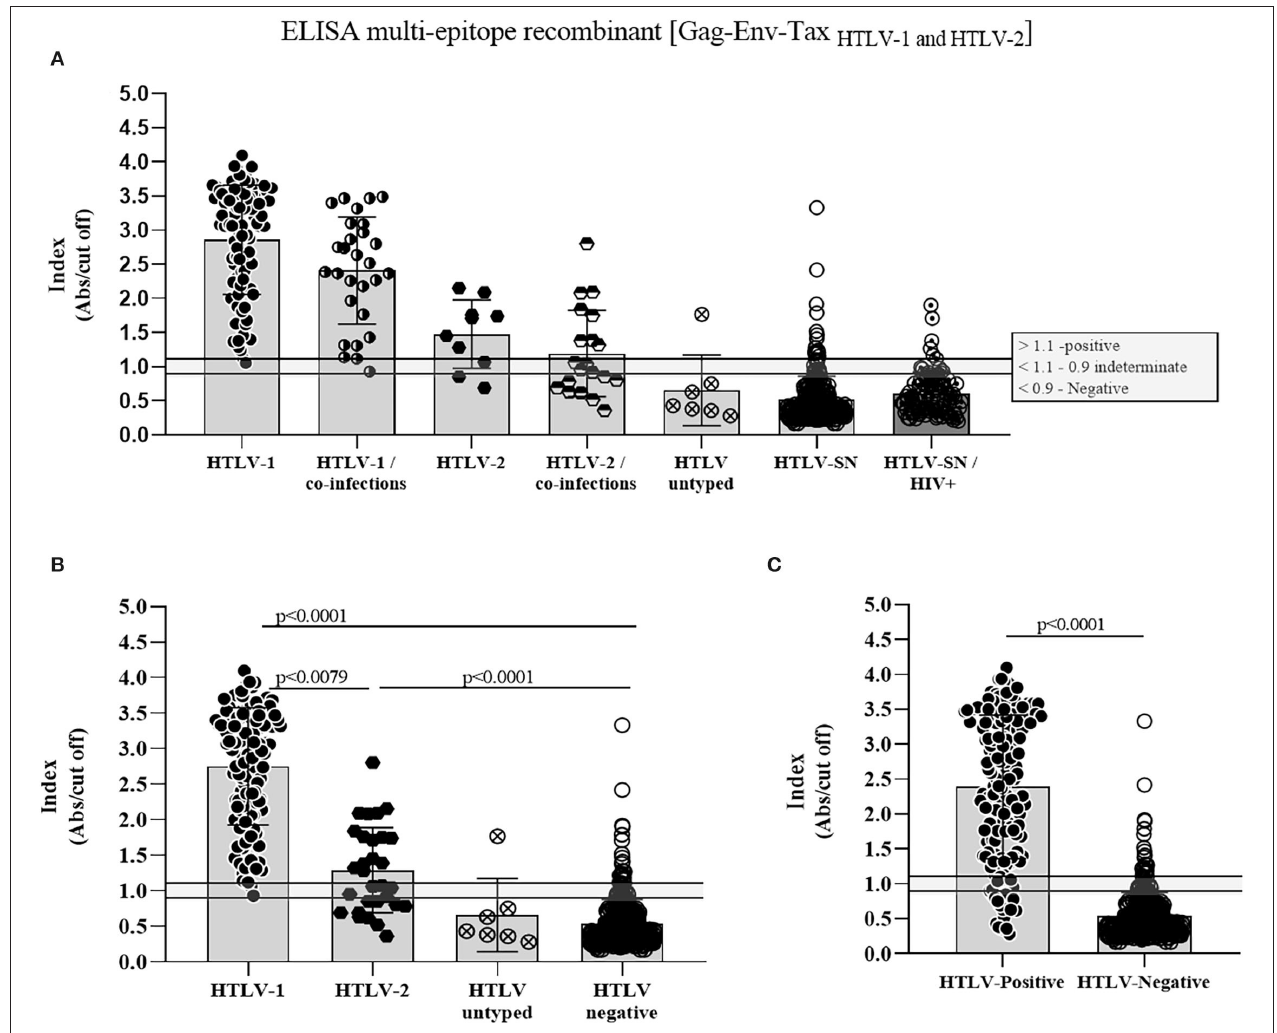
FIGURE 2 | Antibody reactivity of the evaluated HTLV-1, HTLV-2, HTLV, and seronegative samples using the indirect in-house ELISA based on the multi-epitope recombinant protein. (A) Scatter plots show the reactivity against the multi-epitope recombinant protein for all samples tested, which were defined as positive, indeterminate, or negative. HTLV-1 mono or co-infected x HTLV-SN or HTLV-SN/HIV ( p < 0.0001), HTLV-2 mono-infected × HTLV-SN ( p = 0.0005) and × HTLV-SN/HIV ( p = 0.00261), HTLV-2 co-infected × HTLV-SN and HTLV-SN/HIV ( p > 0.05). For HTLV-SN × HTLV-SN/HIV the difference was p = 0.0015. (B) Scatter plots comparing HTLV-1/2 groups with HTLV negative. (C) Comparison between HTLV positive × HTLV negative. Kruskal–Wallis and Mann–Whitney tests were performed in GraphPad Prism